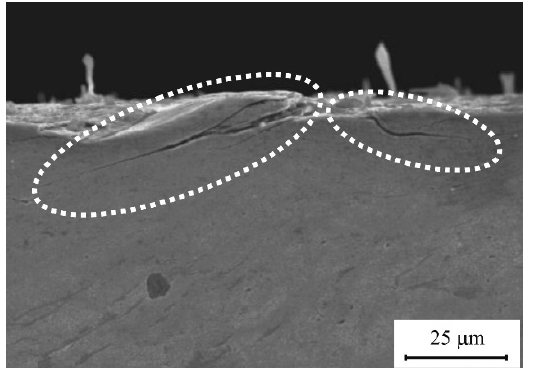
Figure 6. Fatigue crack of wheel/rail specimens without laser cladding (axle load: 25 t, cycle number: 4.8 × 105, Reprinted from Ref. [31], copyright (2014), with permission from Elsevier).